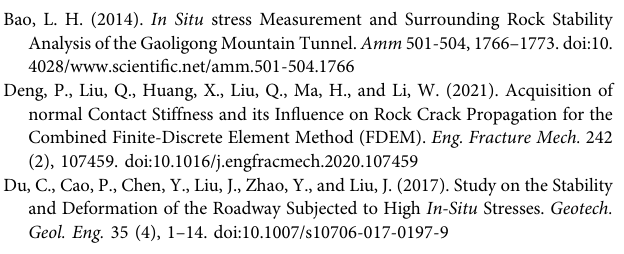
Frontiers in Earth Science |